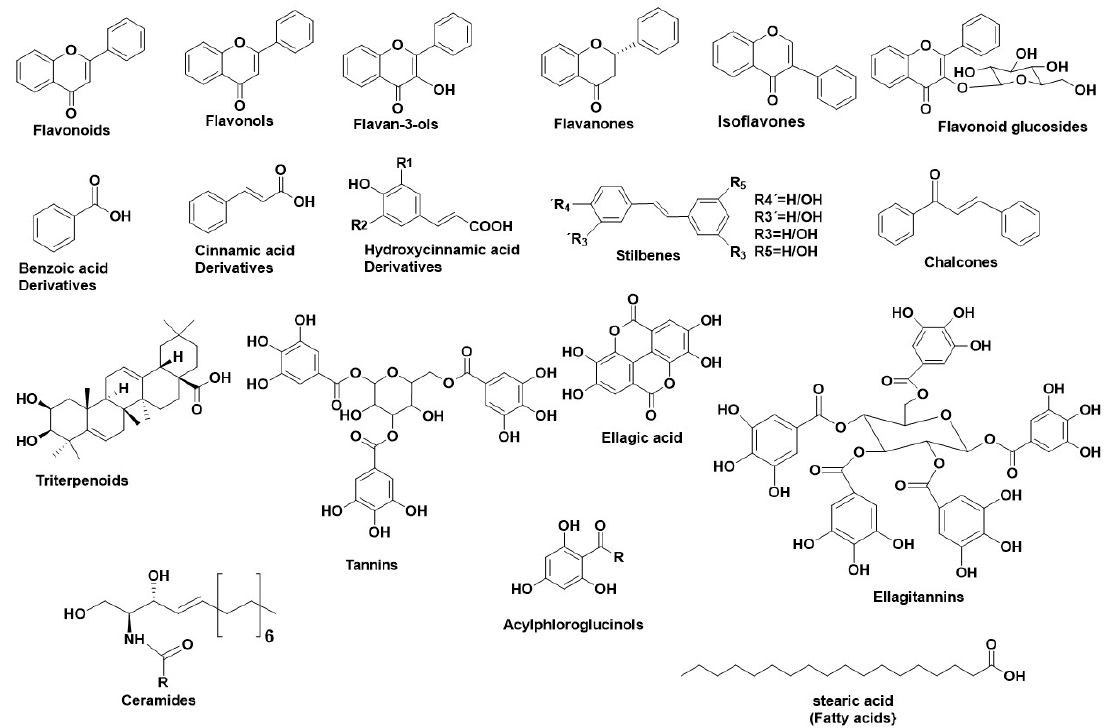
Figure 1. Main structural scaffolds which have been marked as potent HNE